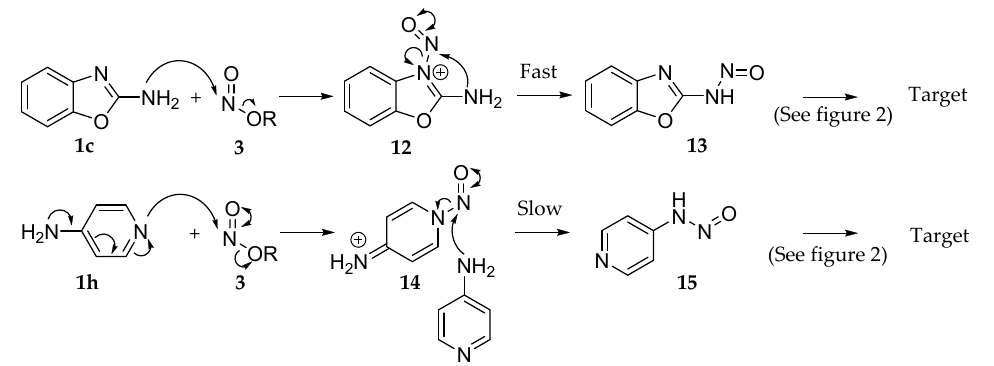
Figure 3. A potential explanation as to why some substrates react more effectively under the presented procedure than